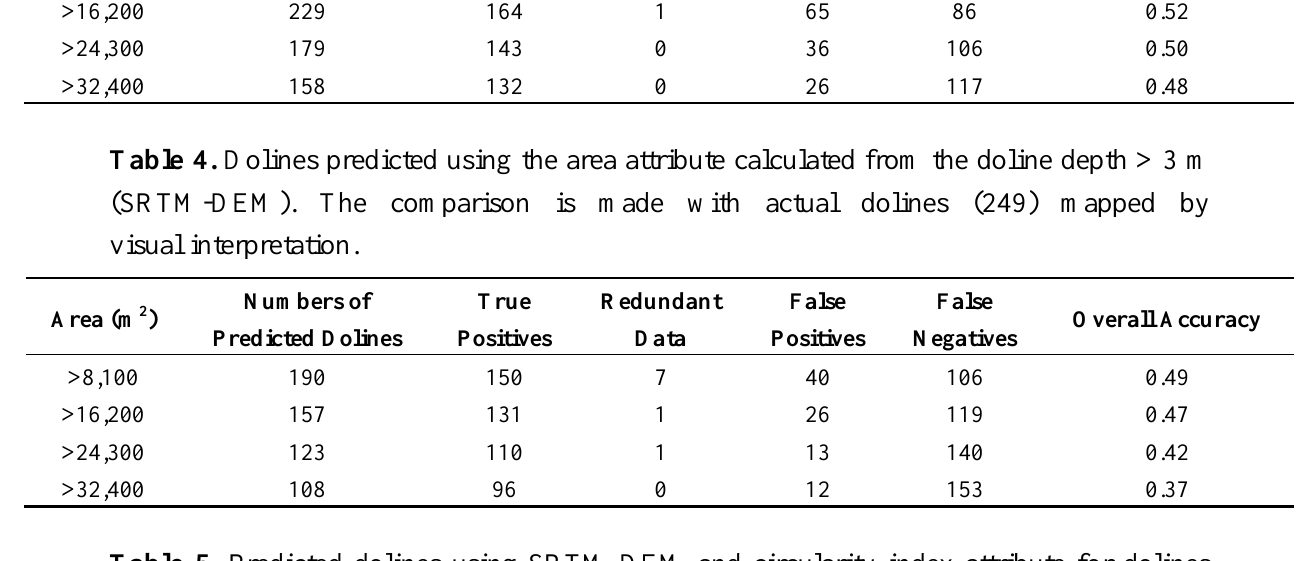
Table 5. Predicted dolines using SRTM-DEM and circularity index attribute for dolines depth > 2 m and area > 16,200. The comparison is made with true dolines (249) obtained by visual interpretation.